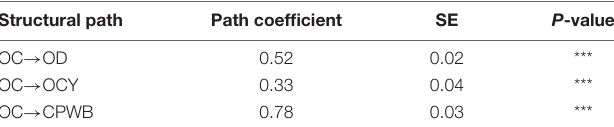
TABLE 3 | Direct paths.